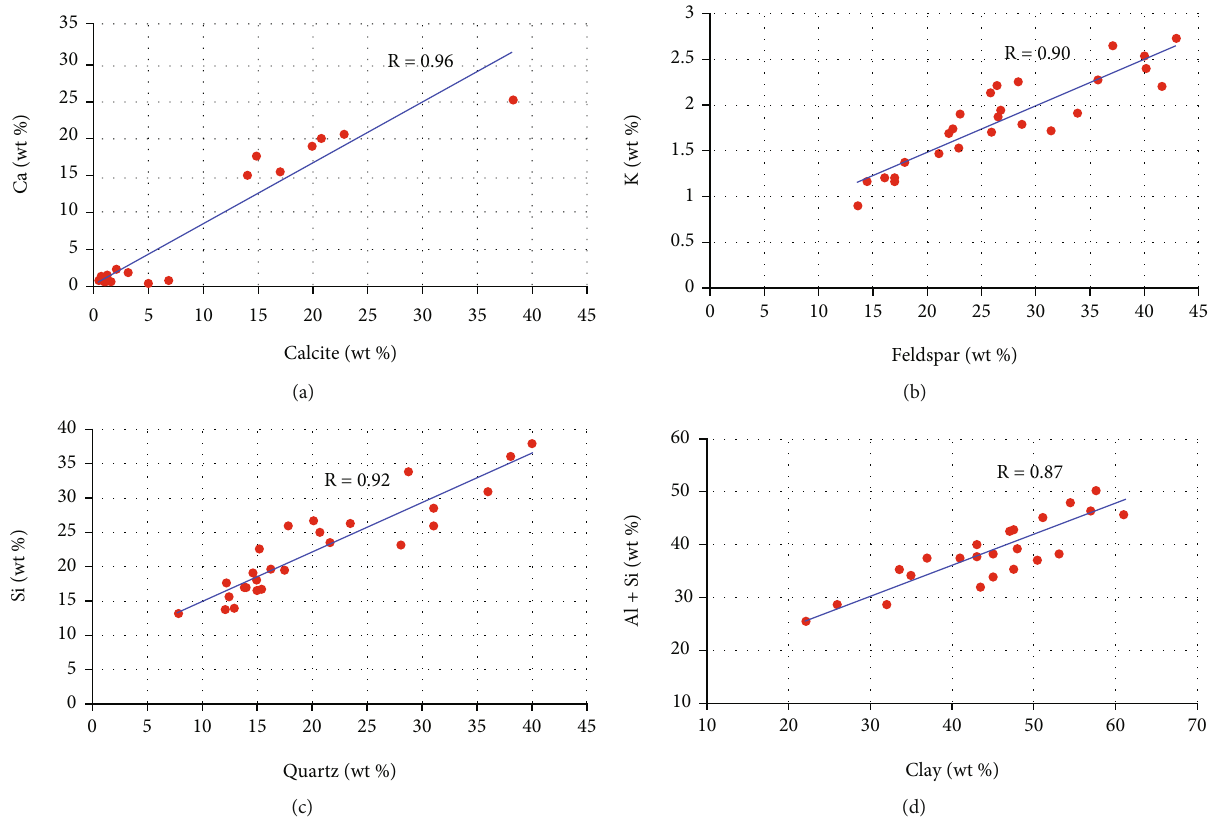
Figure 6: The plots of element content and mineral